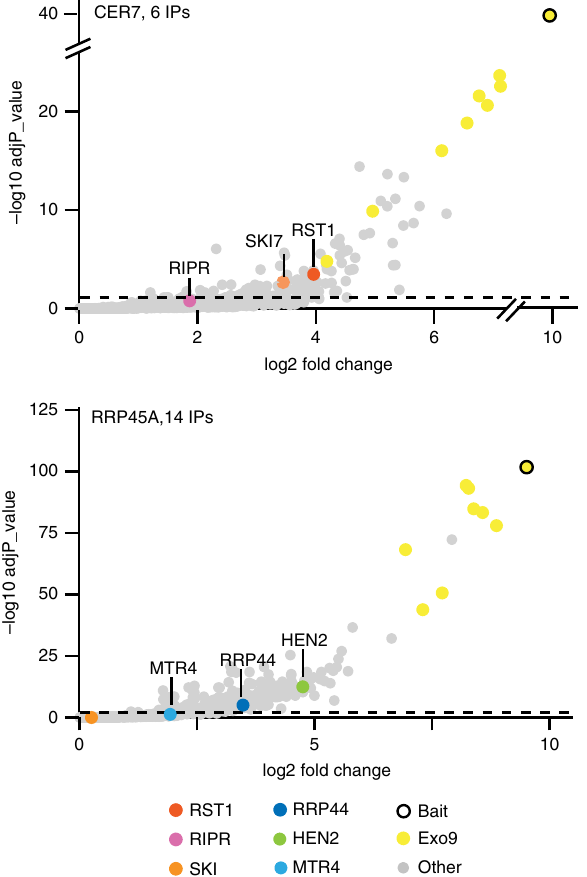
Fig. 5 RST1 and RIPR are bound to CER7-containing exosomes. Volcano plots show the enrichment of proteins co-puri fi ed with GFP-tagged RRP45B/CER7 ( a ) or RRP45A ( b ) as compared with control IPs. Y - and X -axis display adjusted p -value and fold change, respectively. The dashed line indicates the threshold above which proteins are signi fi cantly enriched (adjP< 0.05). The source data are available in Supplementary Data 3